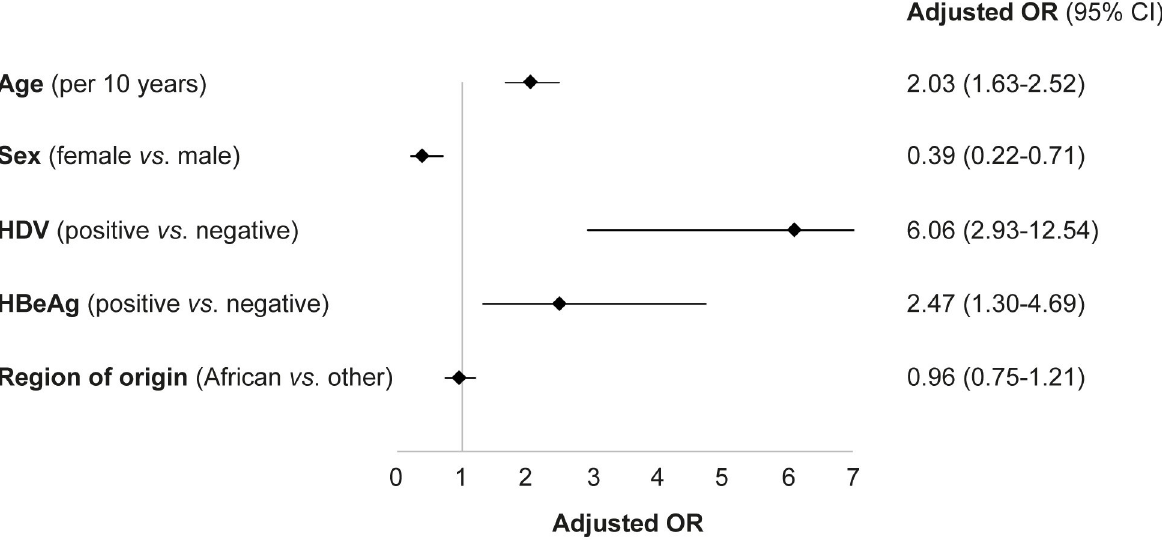
Fig 2. Multivariate analysis for liver-related outcome (cirrhosis, hepatocellular carcinoma, liver transplantation or liver-related death). Analysis was performed by logistic regression, adjusting for all variables in the figure. Results are expressed as adjusted odds ratio (OR) and 95% confidence interval